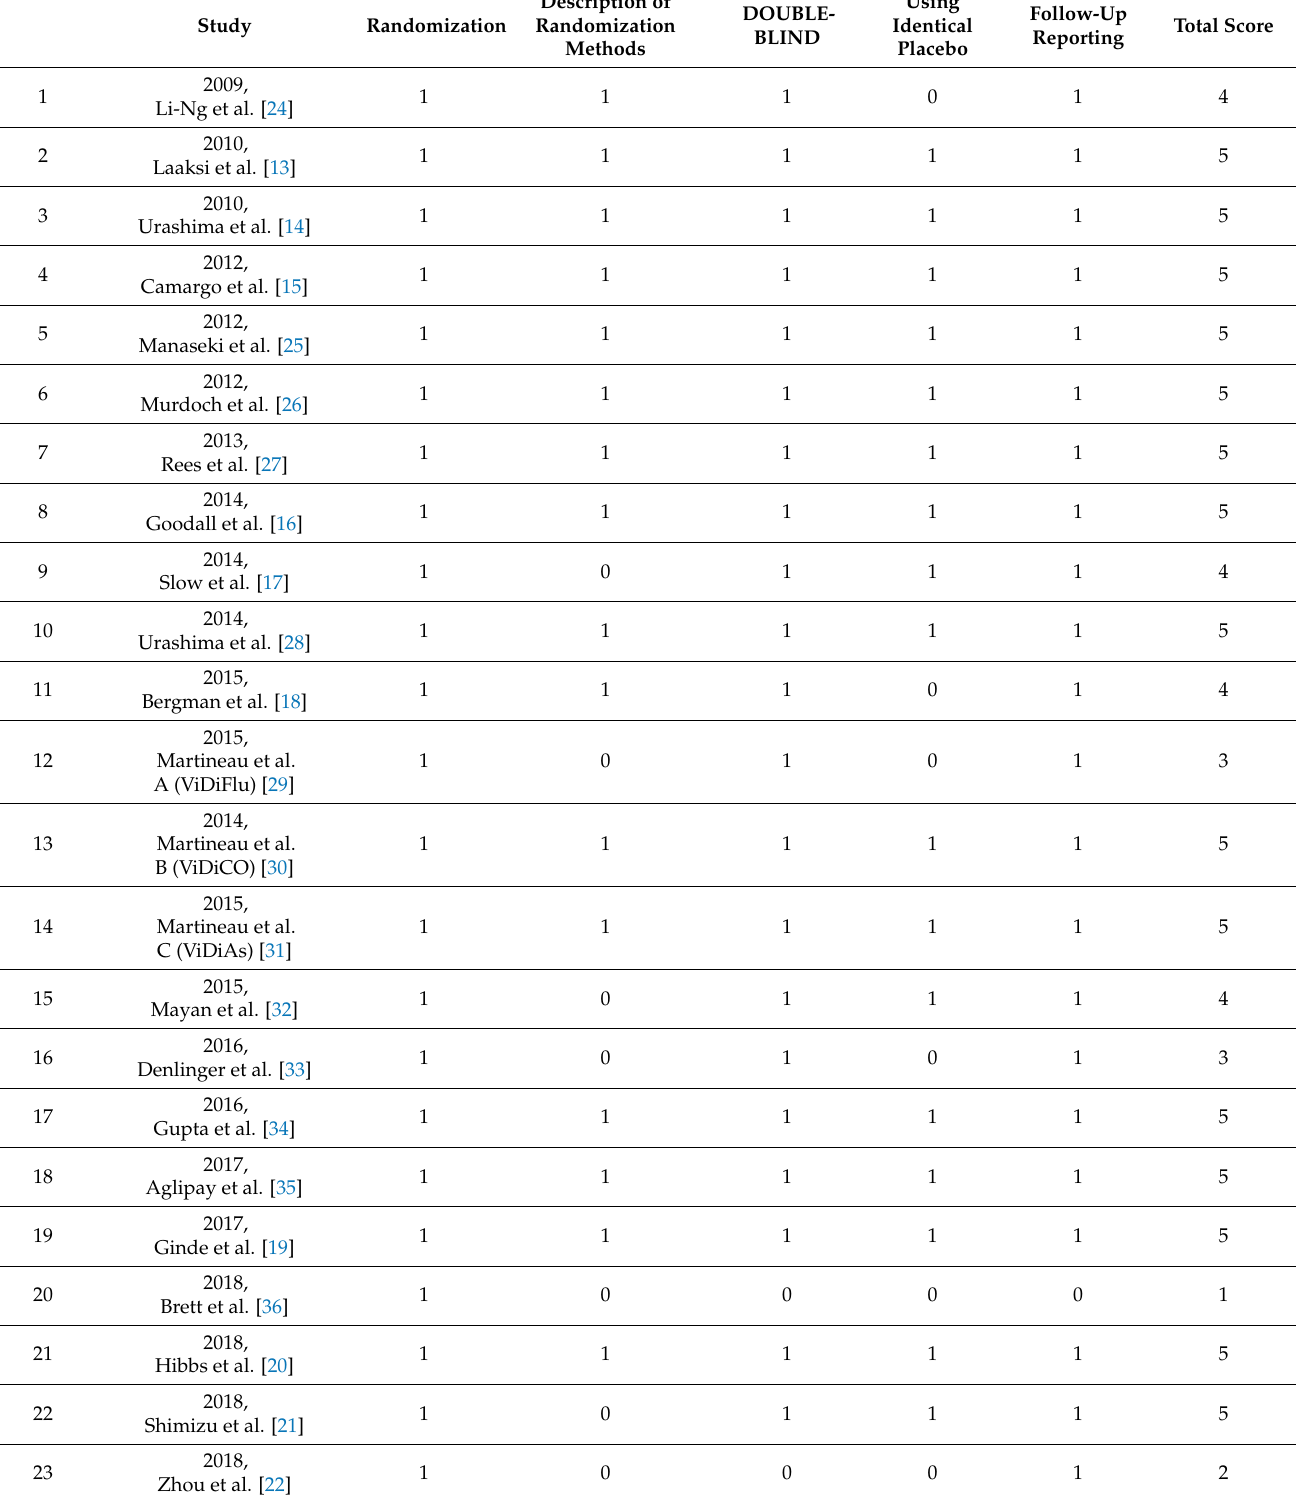
Table 2. Methodological quality of trials based on the Jadad scale ( n =